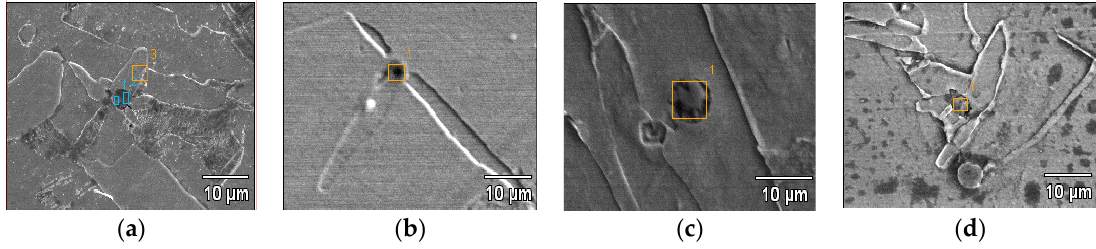
Figure 9. Typical characters of the inclusions which induced intragranular acicular ferrite (IAF). ( a ), inclusion size is about 2.5 μm; ( b ), inclusion size is about 3.0 μm; ( c ), inclusion size is about 7.0 μm; ( d ), inclusion size is about 3.3 μm.